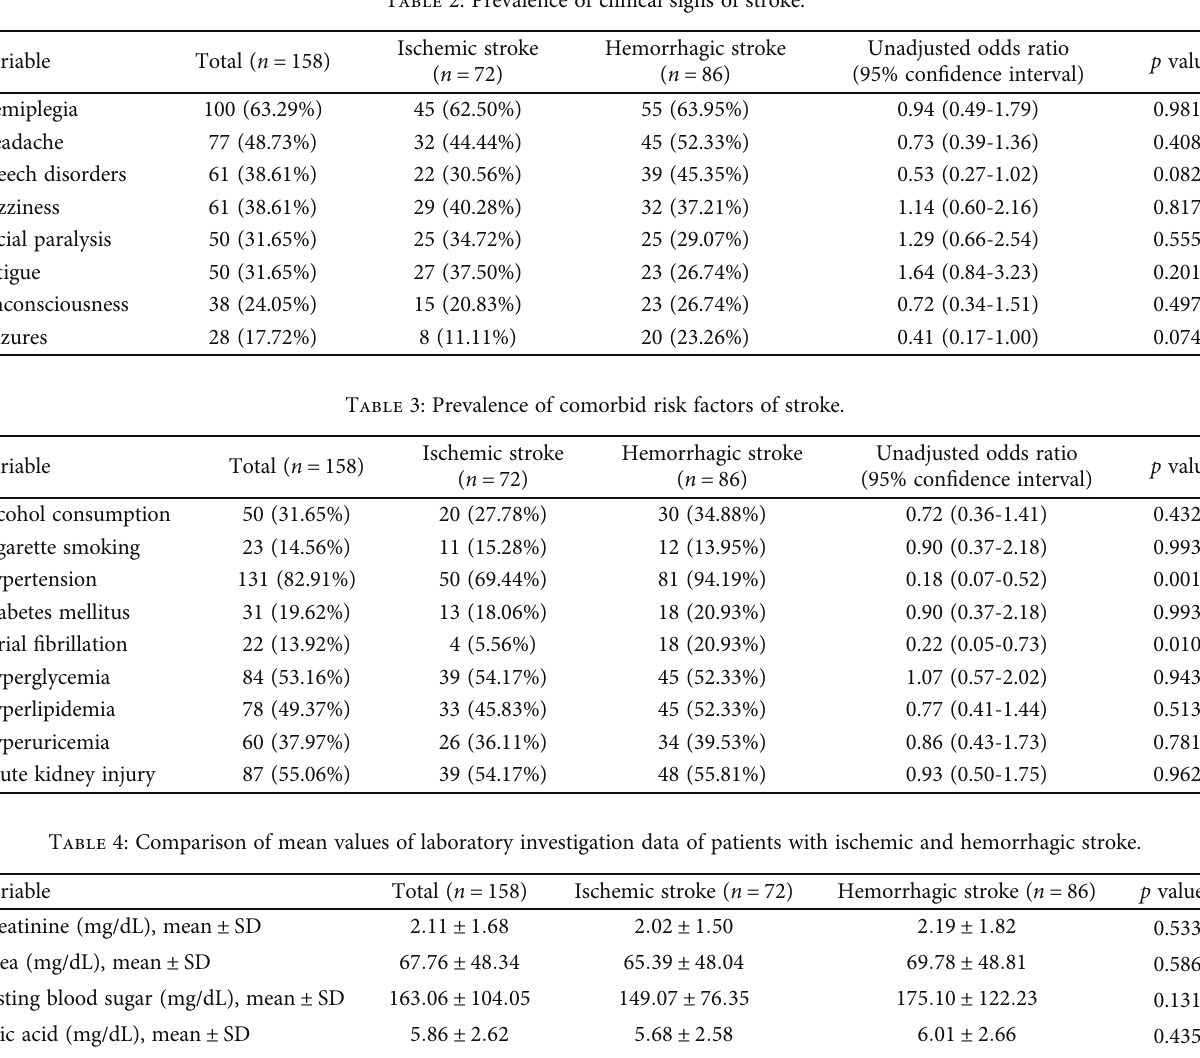
Table 2: Prevalence of clinical signs of stroke.